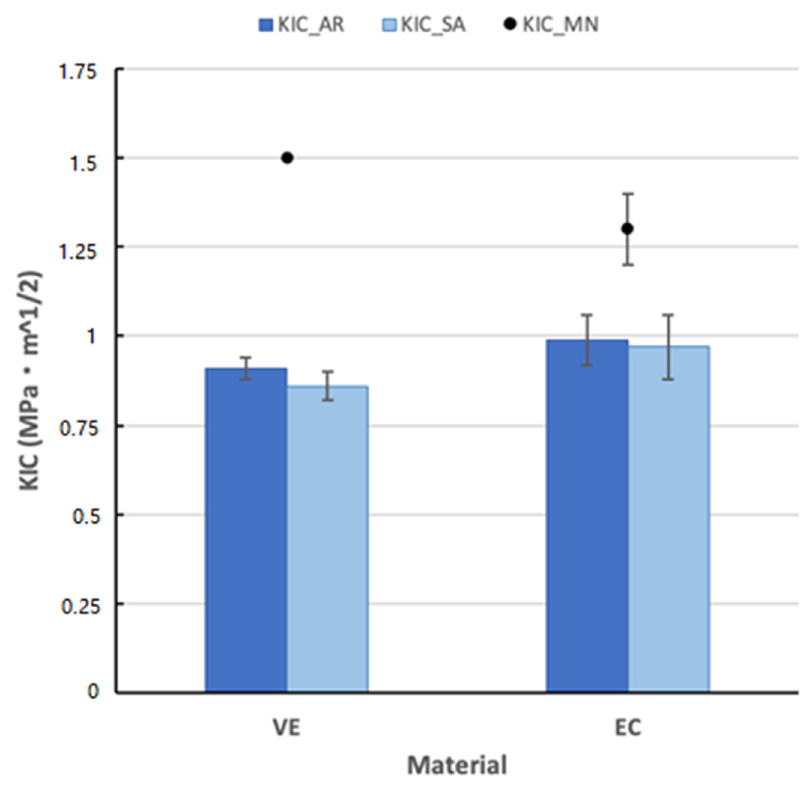
Figure 9. Fracture toughness (mean values and their corresponding root mean square errors) after the TPB tests on the SELNB samples of the materials AR and after immersion in AS and results from the MN.